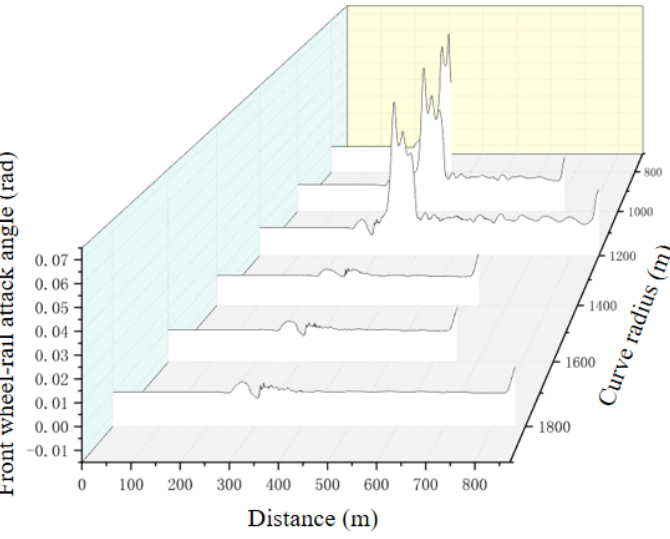
running on group B lines, the wheel–rail attack angle stabilizes to 0 rad when the train runs into the circle curve.